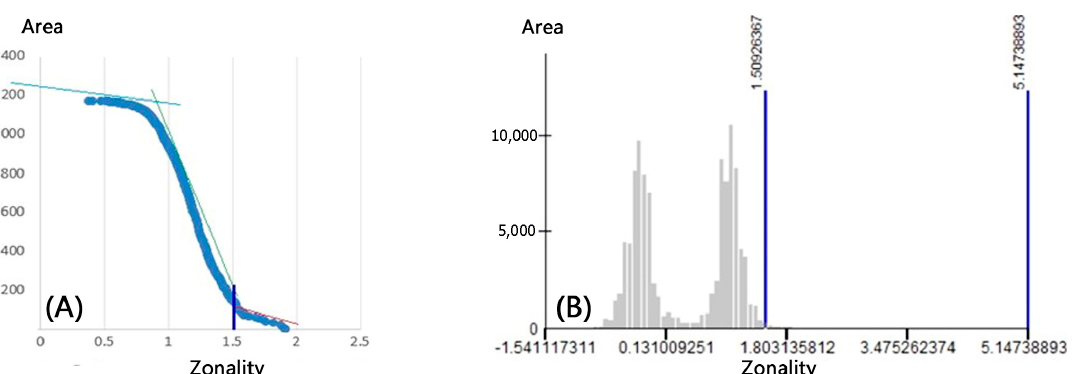
Table 4. Geochemical threshold limits of sub-mineral elements based on C-A multifractal analysis.